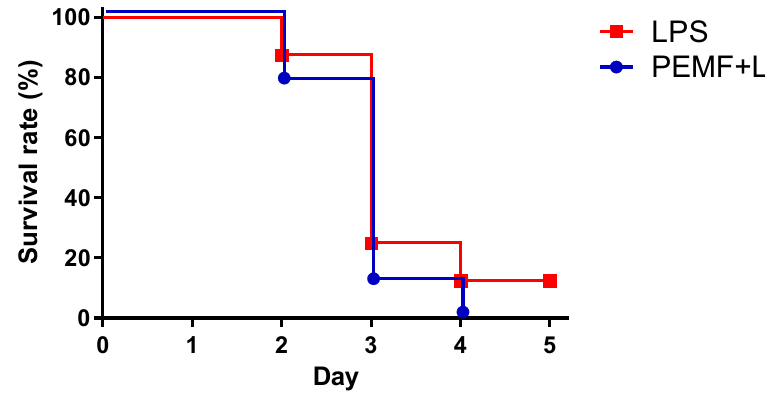
Figure 7. Survival curve of septic shock-induced µ MT mice. Kaplan–Meier curves depicting the survival of the experimental groups. Mice in the PEMF + LPS group were intraperitoneally injected with LPS (7 mg/kg) dissolved in PBS. Mice in the LPS group were injected with LPS (7 mg/kg) only. All mice were exposed to PEMF for up to 5 days. The data were pooled from 2 independent experiments. PEMF + LPS group, n = 9 mice; LPS group, n = 8 mice.